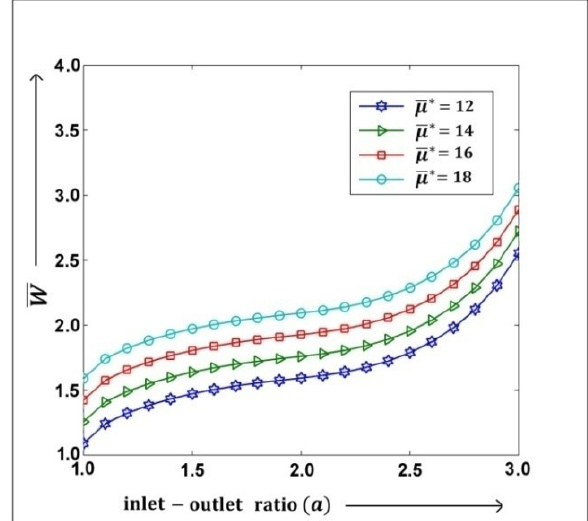
Fig. 9: Lifting force vs. Permeability parameter for different values of the magnetic parameter at 1/¯ s = 1.2, ¯ γ 2 = 1.2, P